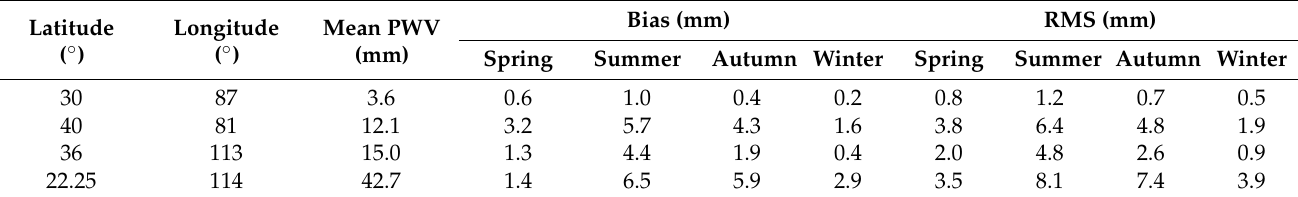
Table 1. Geographical location, seasonal bias, and RMS in the six-year period studied at each of four randomly selected grid